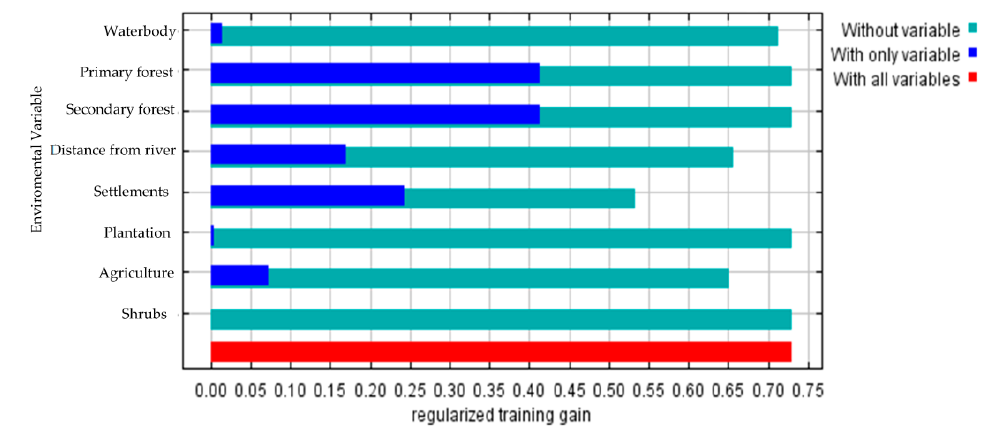
Figure 3. Jackknife evaluation of the relative importance of each variable.